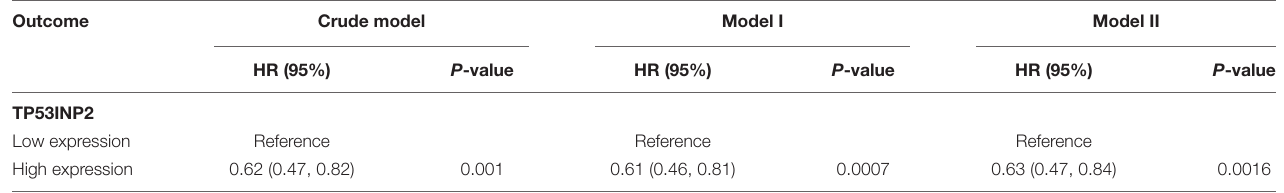
TABLE 1 | Relationship between TP53INP2 and overall survival of HNSCC.